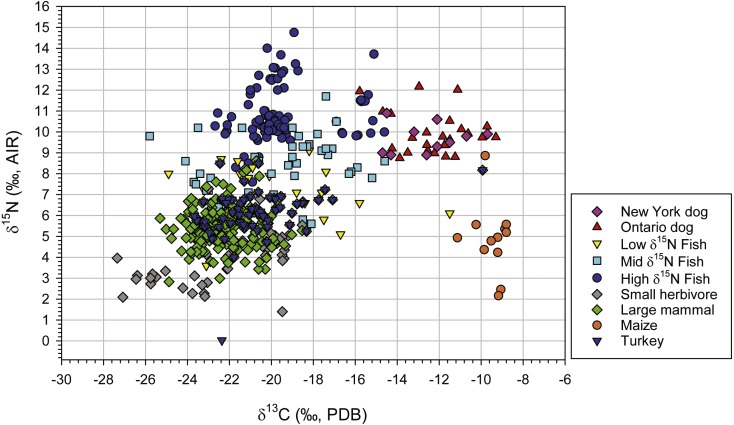
Scatter plot of δ13C and δ15N values for dogs and prey groups used in the seven source Bayesian dietary mixing model.